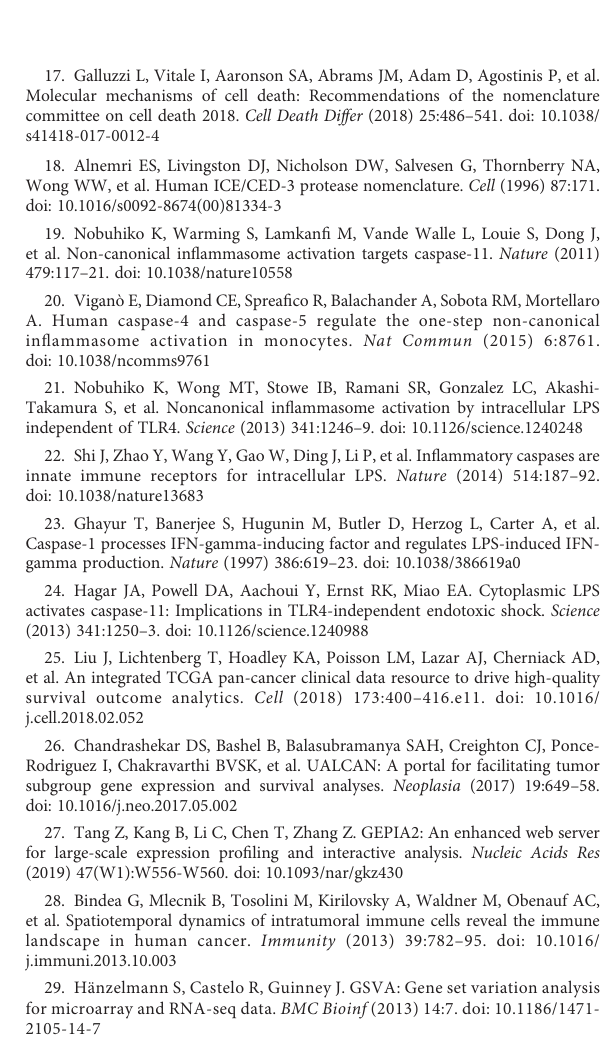
SUPPLEMENTARY TABLE 1 Clinicopathological characteristics associated with CASP4 expression in glioma patients. SUPPLEMENTARY TABLE 2 Correlation between clinicopathological characteristics and overall survival of glioma patients in the univariate or multivariate Cox regression analysis.Values shown in bold are statistically signi fi cant ( P < 0.05). SUPPLEMENTARY TABLE 3 Results of the Gene Set Enrichment